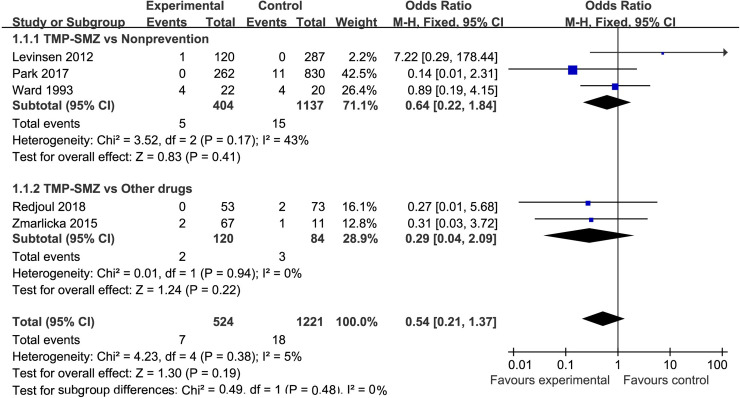
Forest plot of the rate of mortality.The vertical line indicates no difference between the groups. ORs are represented by diamonds, and 95% CIs are depicted by horizontal lines. Squares indicate point estimates, and the size of each square indicates the weight of the given study in the meta-analysis. M-H, Mantel-Haenszel fixed-effects model.